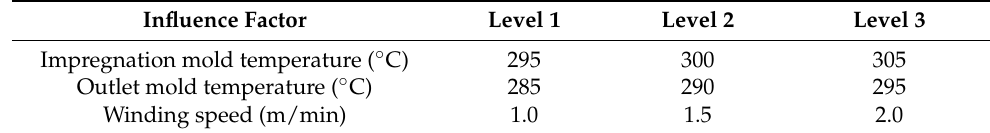
Table 5. Factor level value table.